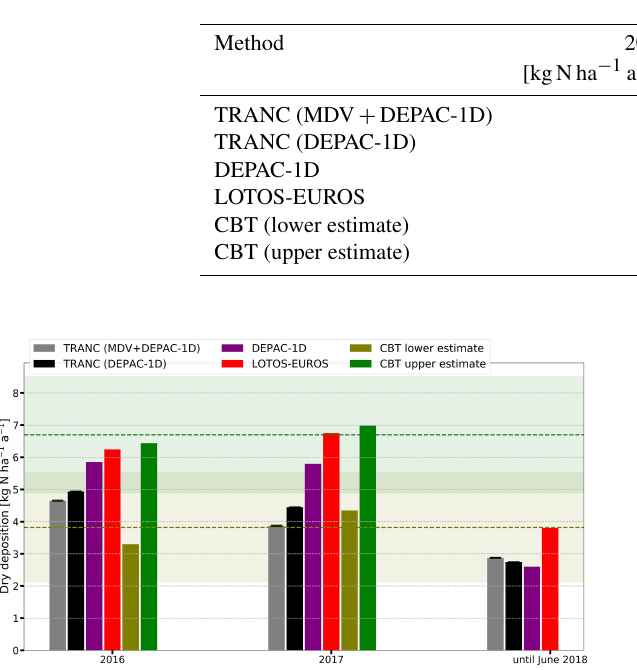
Table 2. (cid:54) N r dry deposition of TRANC, DEPAC-1D, LOTOS-EUROS, and CBT for the entire measurement campaign, i.e., January 2016 to June 2018. Results from CBT were weighted according to the measured land-use weighting. For a visualization of the annual dry deposition, see Fig. 8.